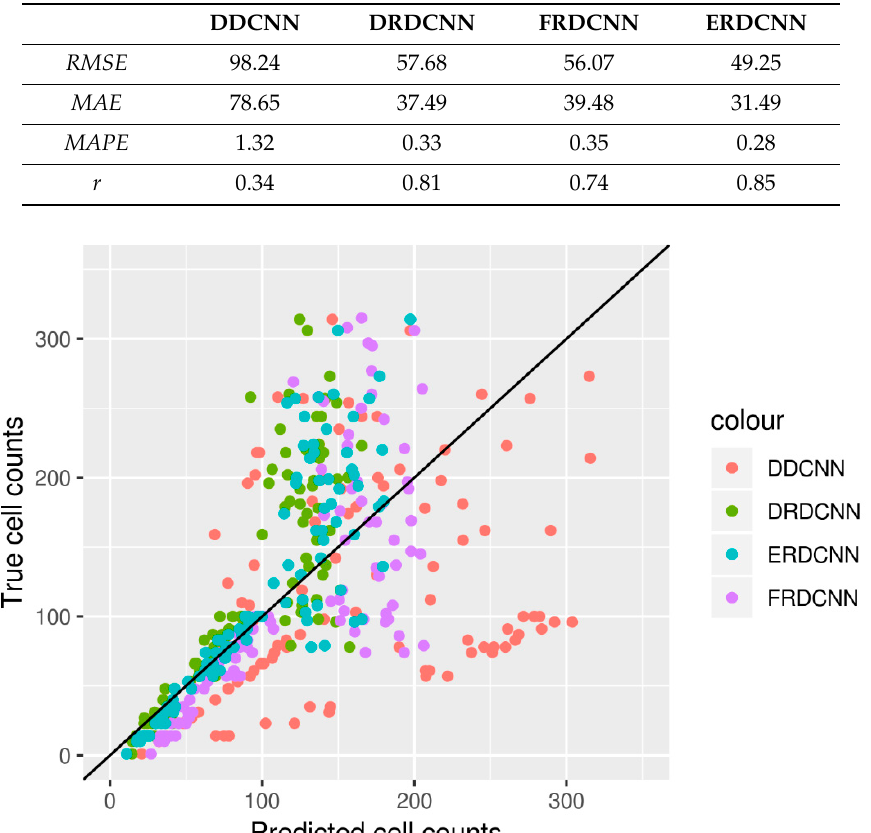
Figure 4. Density plots of the predicted cell counts for the three experimental groups from the four models. ( A ) Each plot compared the predictions of the three experimental groups using the same model. ( B ) Each plot compared the predictions of the four models for the same experimental group.